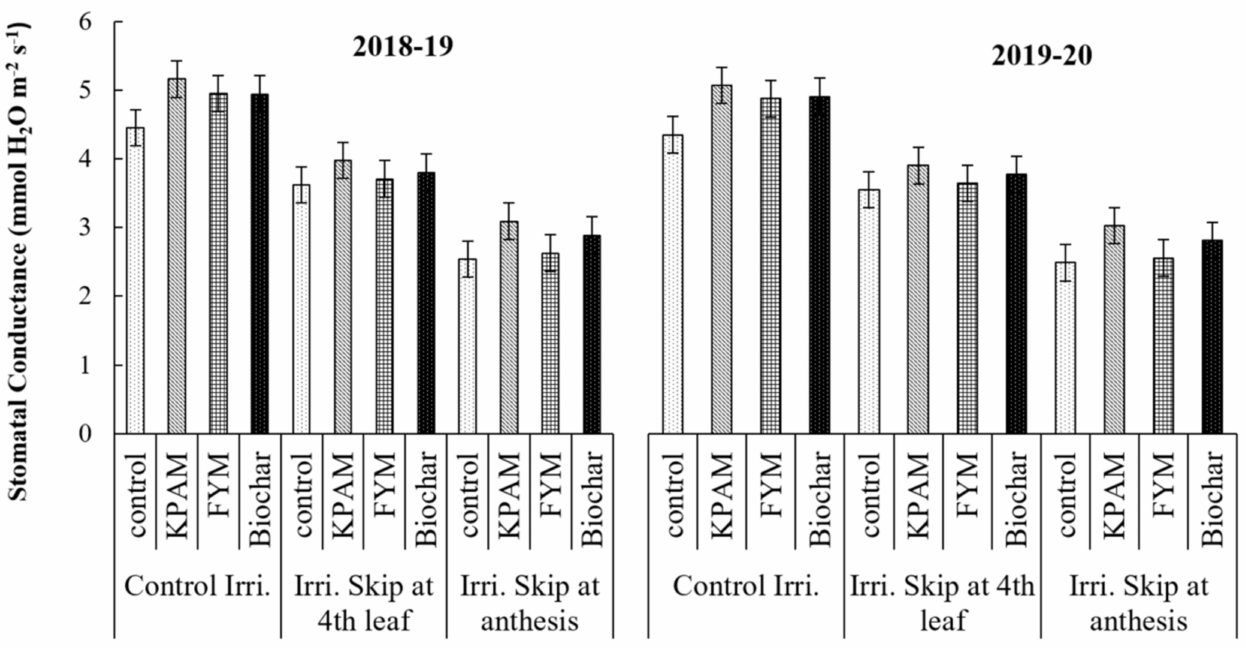
Figure 6. Effect of soil amendment materials on stomatal conductance in the wheat crops grown under normal and water stress imposed by skipping irrigation at 4th leaf and anthesis stage of growth (mean values ± S.E).